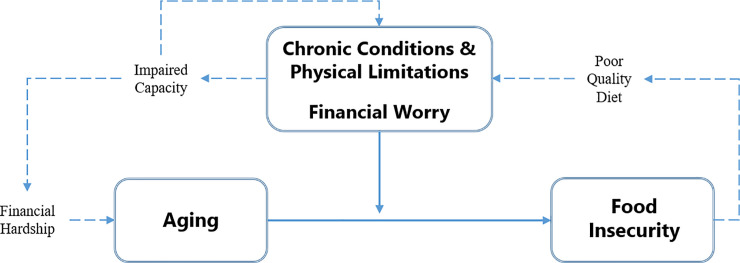
Conceptual model of accelerated aging and food insecurity in midlife: Cascading impact of poor diet quality, health challenges, financial hardship, and financial worry.